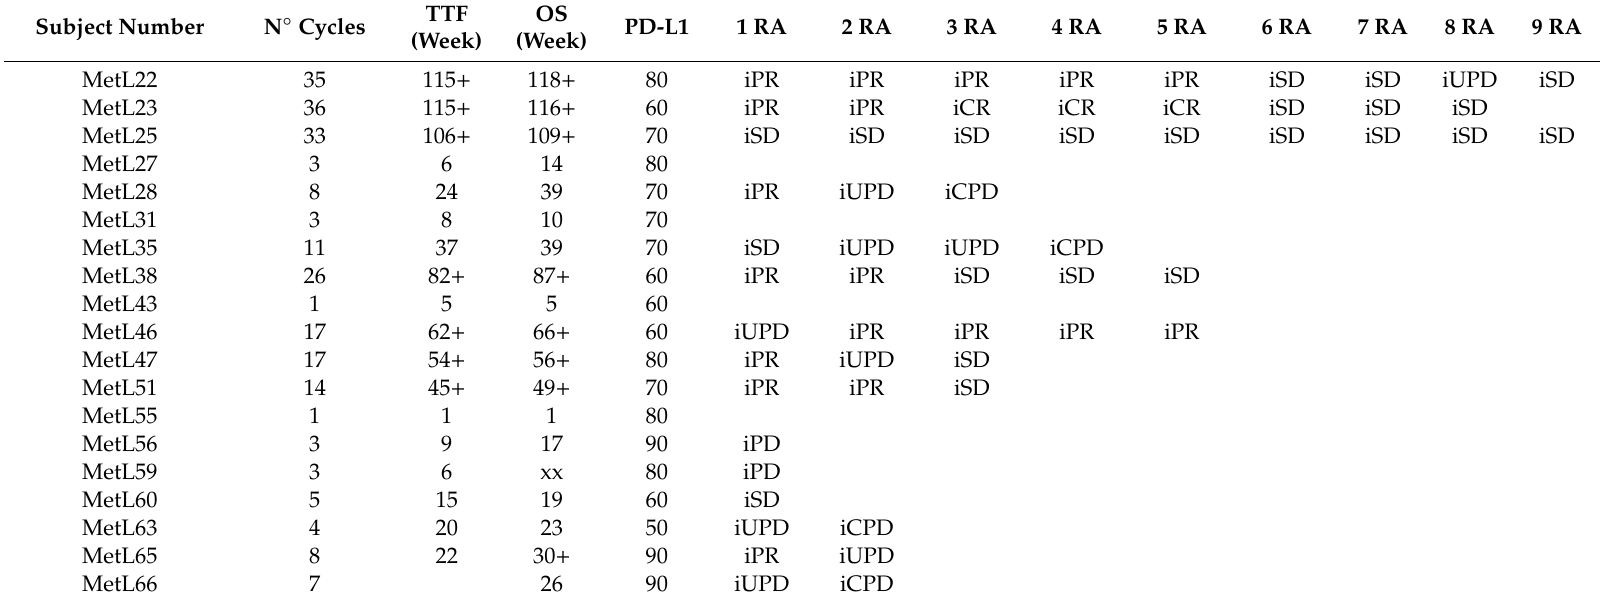
Table 2. NSCLC Pembrolizumab -treated cohort. For each patient the (i) number of cycles of pembrolizumab therapy performed, (ii) time of treatment failure (TTF), (iii) overall survival (OS), (iv) PD-L1 expression levels; (v) iRECIST classification for the radiological assessments (RA), are reported: complete response (iCR), partial response (iPR), stable disease (iSD), unconfirmed progressive disease (iUPD), confirmed progressive disease (iCPD) and hyper-progression (iHP). Patients considered responders are highlighted in